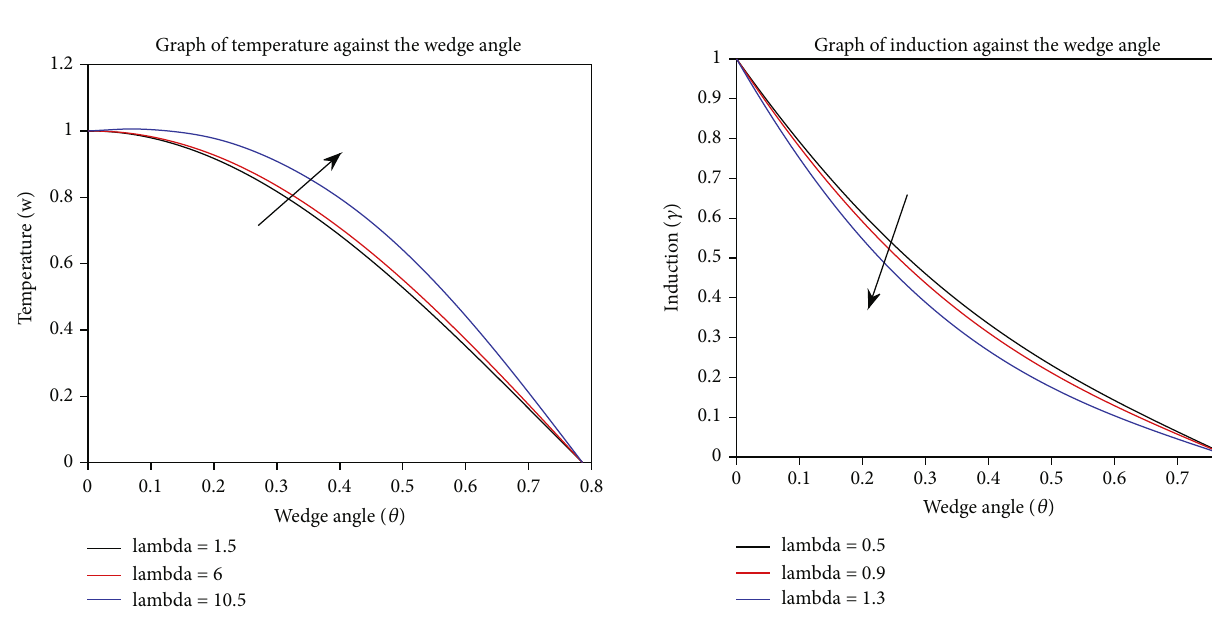
Figure 16: E ff ect of varying the unsteadiness parameter on magnetic induction. Table 1: Skin friction coe ffi cient and the Nusselt number values on variation of the fl ow parameters, i.e., the Reynolds number, the Hartmann number, the Joule heating parameter, and the unsteadiness parameter.